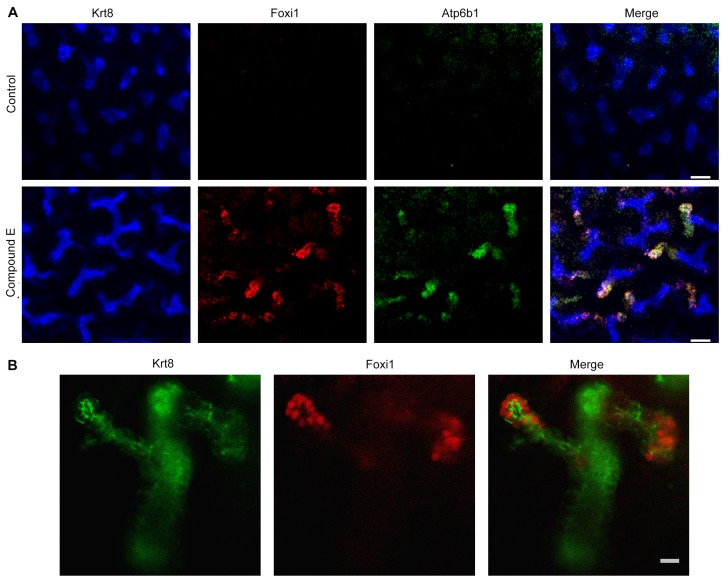
Manipulation of Notch signaling in vivo.(A) Inhibition of Notch signaling upregulates Foxi1 and promotes IC cell differentiation. Acute inhibition of Notch signaling in E15 kidneys with Compound E (48 hr) resulted in the differentiation of IC cells at the tips of the UB/Collecting Ducts. Note that the IC cells demonstrated a ‘double-positive’ phenotype with the co-expression of PC (Krt8+ blue) and IC (Foxi1+ red, Atp6b1+ green) proteins. (B) High power of Compound E treated kidneys (n = 6 independent mouse kidney cultures). (A) Bars = 50 µm and (B) Bar = 10 µm.